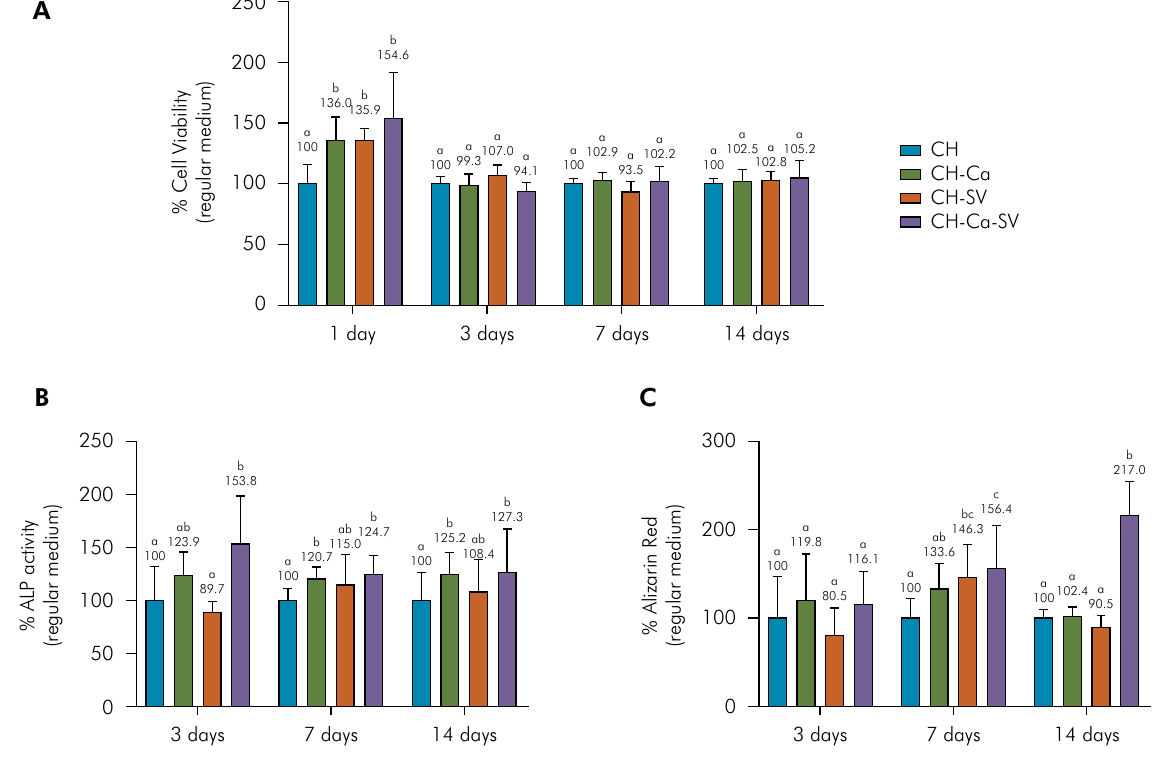
Figure 5. Extract assay. (a), (b), and (c) representative graphs of cell viability, ALP activity, and Alizarin Red assays, respectively. Values represent means, and different letters indicate statistically significant differences between groups (one-way ANOVA followed by Tukey’s. n = 6, p <0.05).